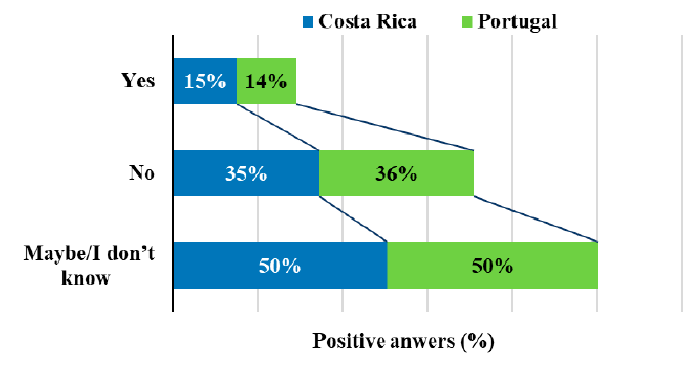
Figure 7. Availability of EF.